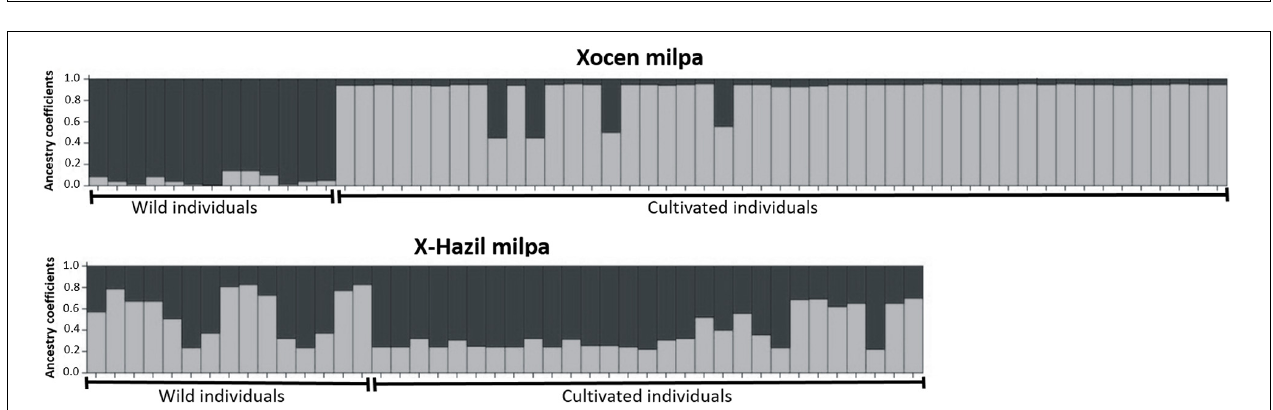
FIGURE 9 | Coefficients of estimated ancestry per individual of 12 cultivated (D), 9 wild (W), and 3 weedy (We) populations of Lima beans from Yucatán Peninsula, Mexico, using 9 microsatellite loci and the Structure program. Each individual is represented by a single vertical line broken into two colored segments (wild, gray; cultivated, black), with lengths proportional to the individual’s estimated ancestry fraction from each of the two biological statuses. A wild population was considered as weedy when it had 20% or more ancestry from the cultivated gene pool. Modified from Martínez-Castillo et al. (2007).